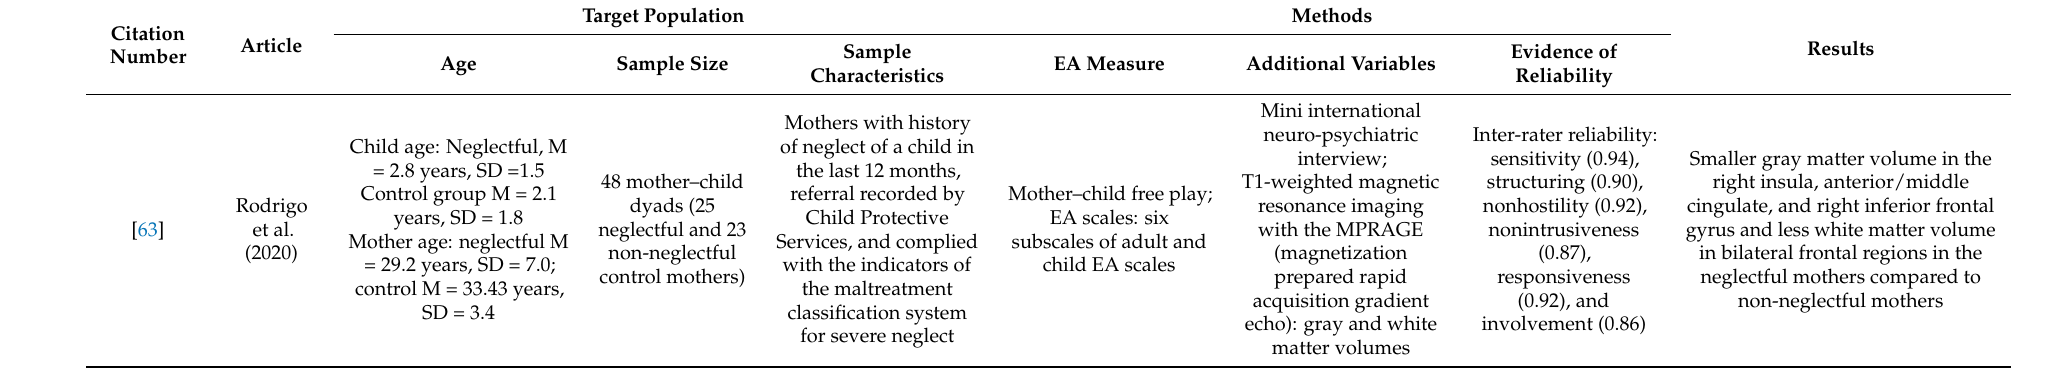
Table 3. Characteristics of studies included in the review with brain mechanisms